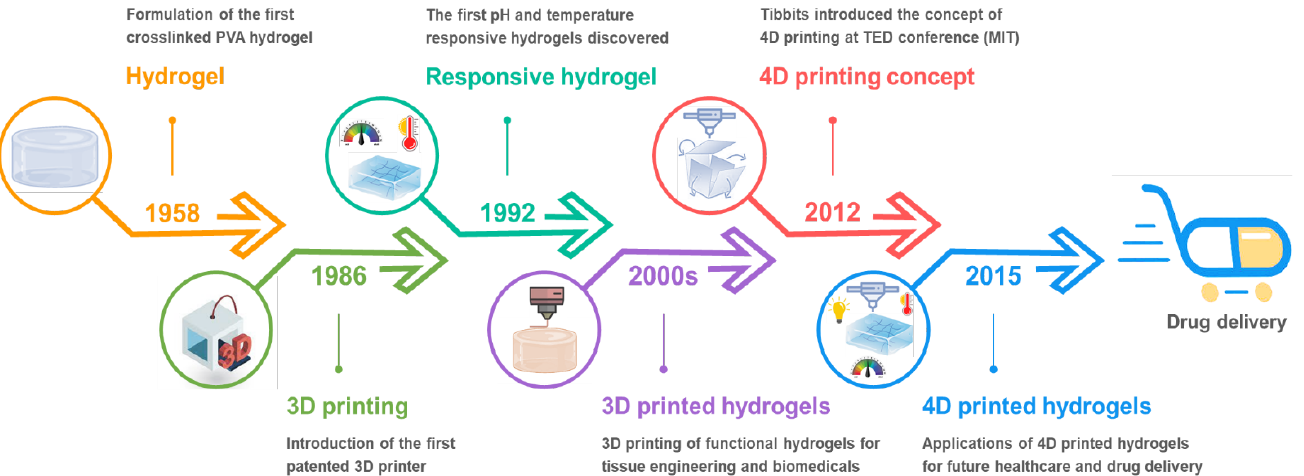
Figure 1. A brief history of the 4D printed smart hydrogels for drug delivery applications. Created with BioRender.com.